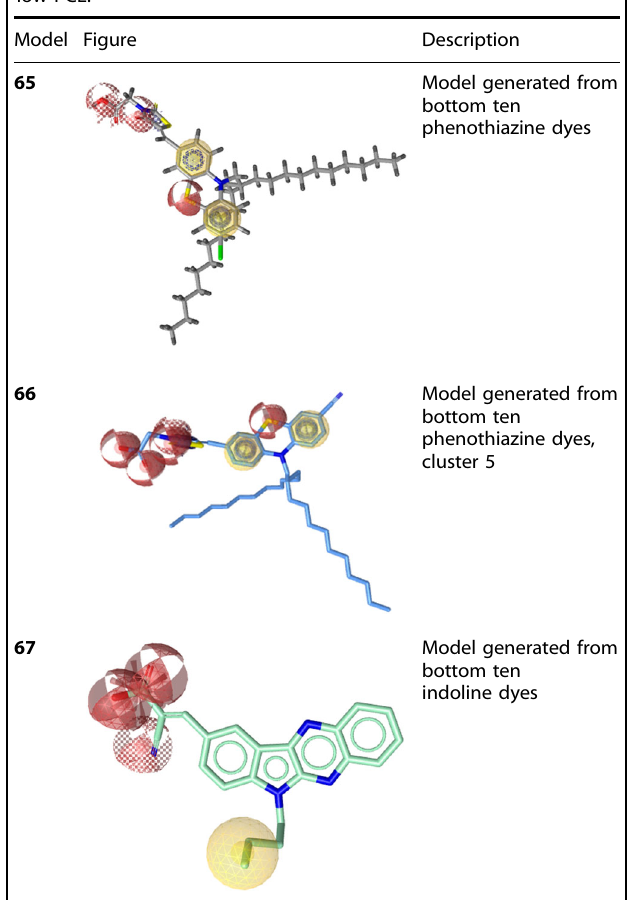
Table 5. AUC, EF 1% , MCC, %HA, and %LA values of the selected pharmacophore